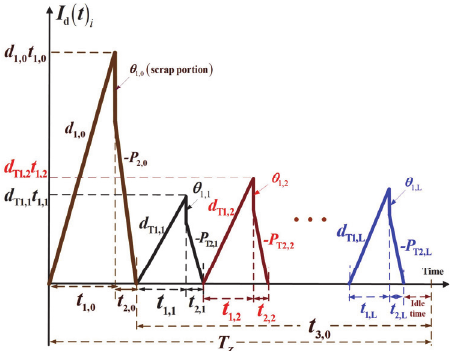
Fig. 3. The status of defective items in a replenishment cycle of our proposed model